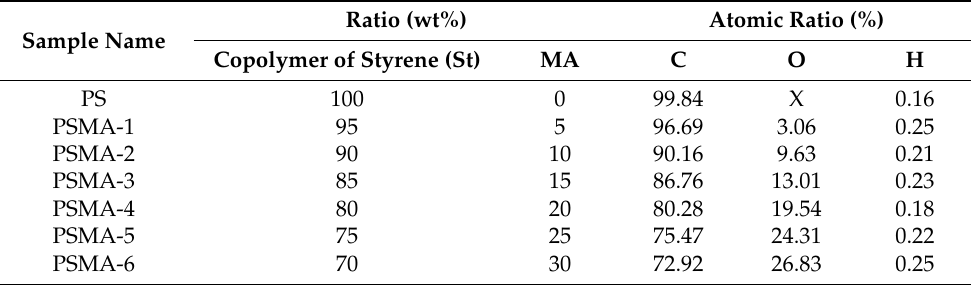
Table 1. Elemental analysis (EA) of PSMA based on the addition of maleic anhydride (MA).